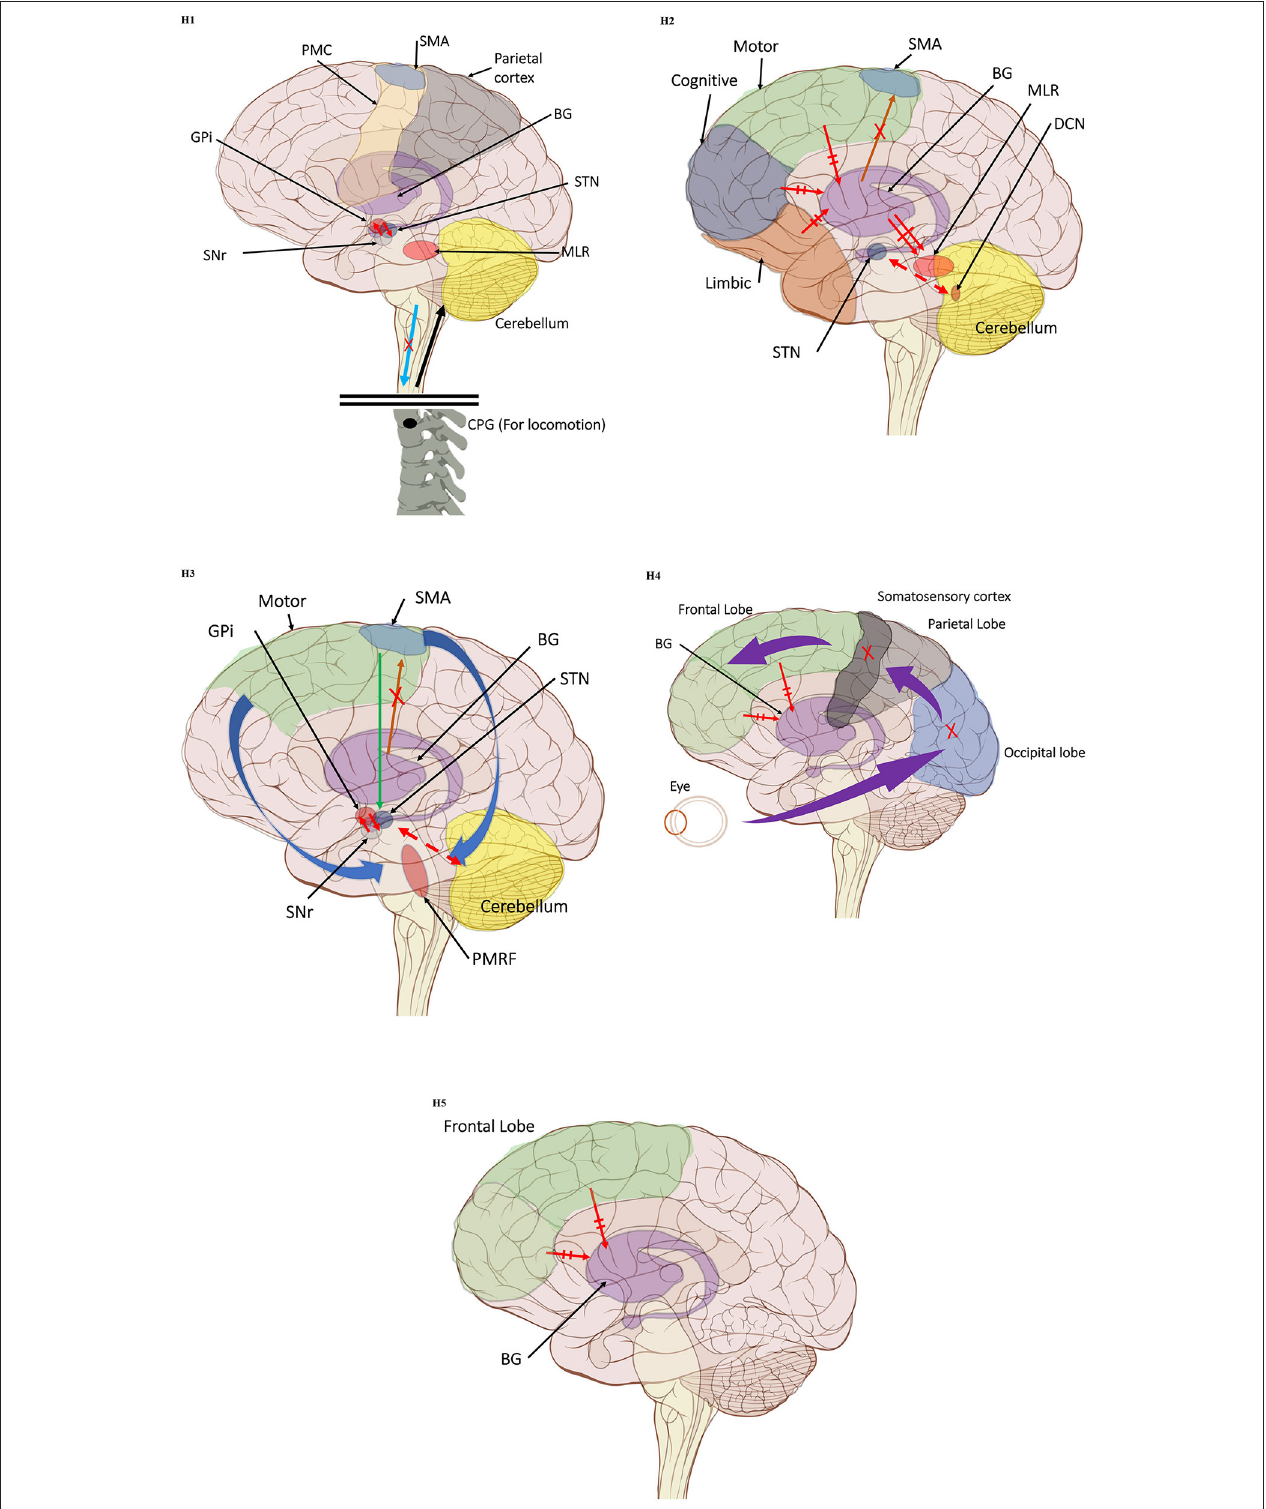
FIGURE 1 | (H1) Abnormal control outputs from central pattern generators. The supraspinal locomotor network (SLN) is composed of the premotor cortex (PMC), supplementary motor area (SMA), parietal cortex, basal ganglia (BG), subthalamic nucleus (STN), mesencephalic locomotor region (MLR), and cerebellum. ↓ In